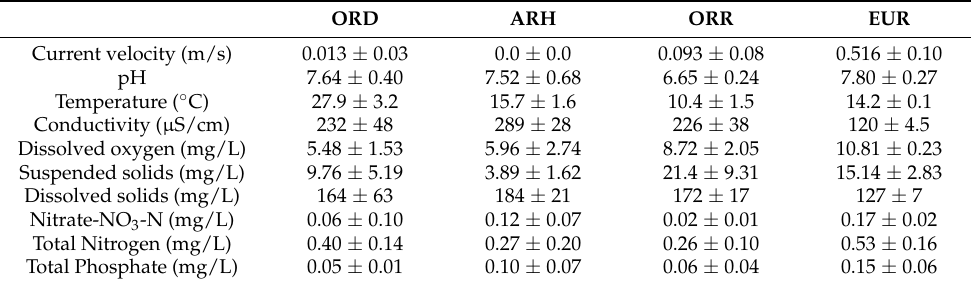
Table 2. Summary of the environmental variables (mean ± standard deviation) measured in the different aquatic states at Table 2015. (see acronyms of aquatic states in Figure 3).